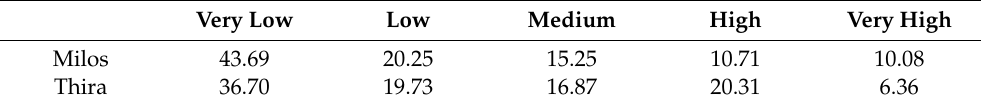
Table 9. Percentages of susceptibility classes to tsunami run-up scenario in Milos and Thira islands. Very Low Low